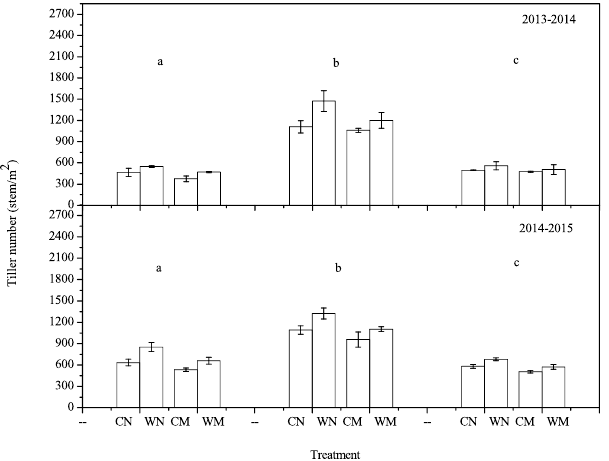
Figure 4. Tillers number at the overwintering stage ( a ), jointing stage ( b ), and heading stage ( c ) in 2013–2014 and 2014–2015 winter wheat growing seasons. WN represent wide-precision planting with non-mulching, CN represent conventional-cultivation planting with non-mulching, WM represent wide-precision planting with straw mulching, and CM represent conventional-cultivation planting with straw mulching, respectively. Vertical bars are standard errors.